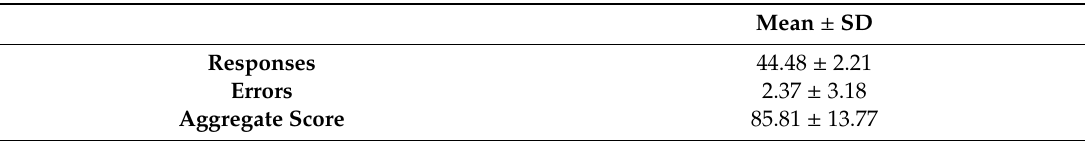
Table 2. PVT-B measures.